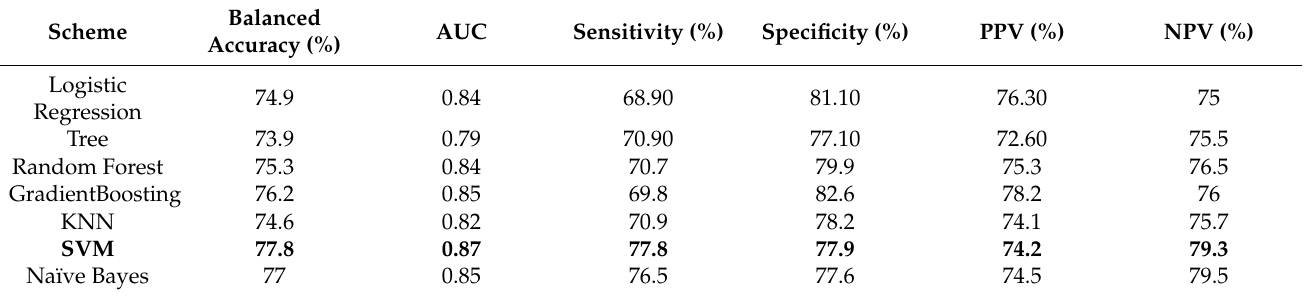
Table 2. Machine learning models and their performance in cross-validation (nested resampling).